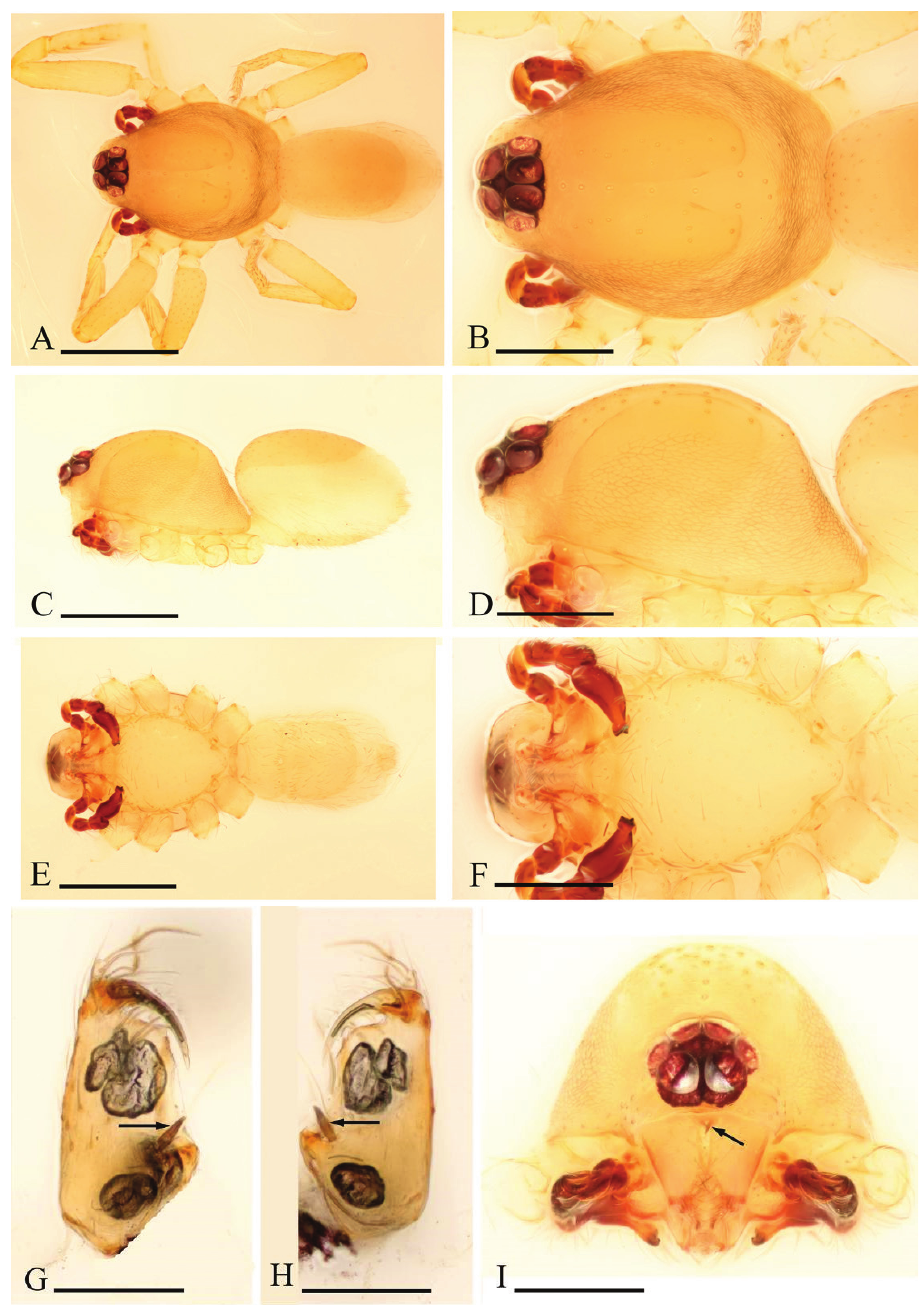
Figure 1. Ischnothyreus an sp. n., male. A, C, E habitus, dorsal, lateral and ventral views B, D, F, I prosoma, dorsal, lateral, ventral and anterior views G, H left chelicera, anterior and posterior views. Arrows show the thorn-like protrusion. Scale bars: A, C, E = 0.4 mm; B, D, F, I = 0.2 mm; G, H = 0.1